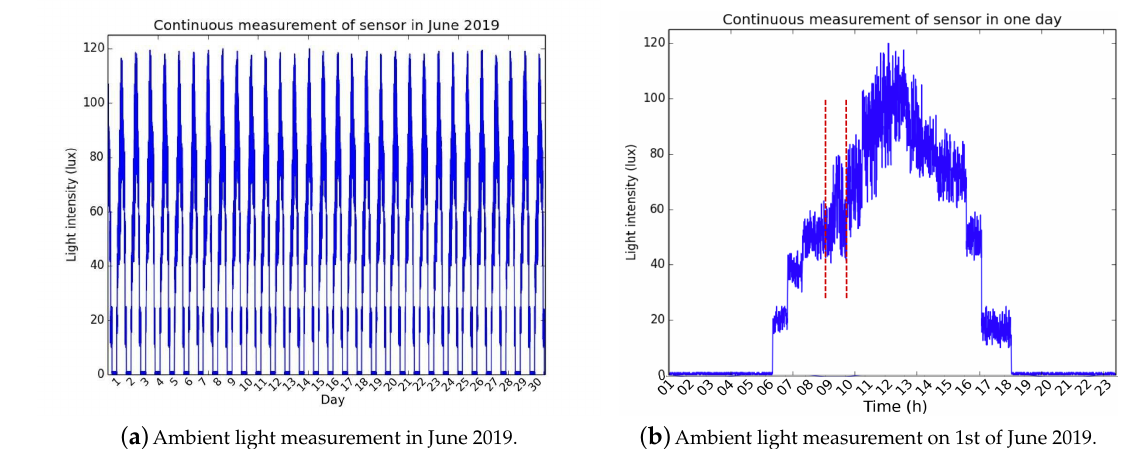
Figure 8. Ambient light measured by the light sensor.